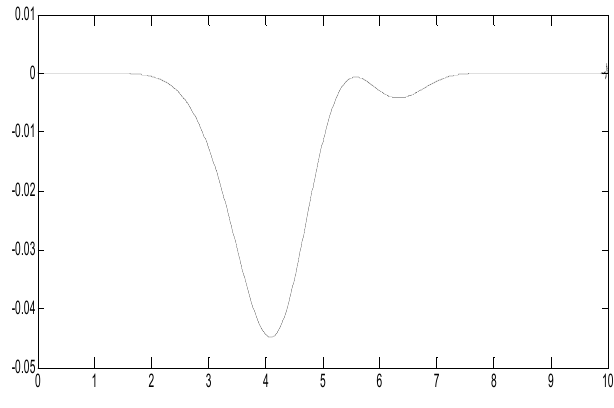
Figure 21. Case 2: Evolution of the control law u 2.